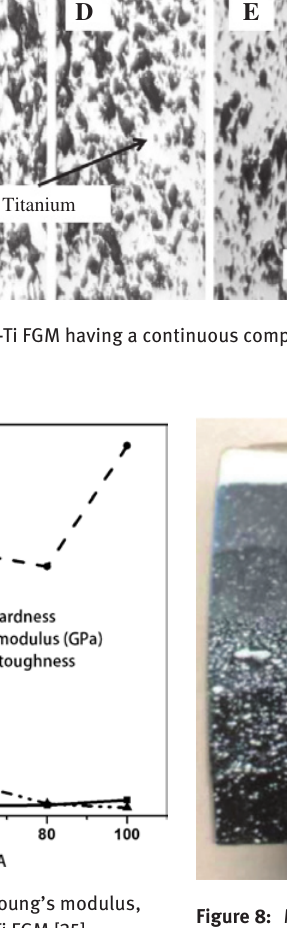
Figure 8: Microstructure of Al compositions